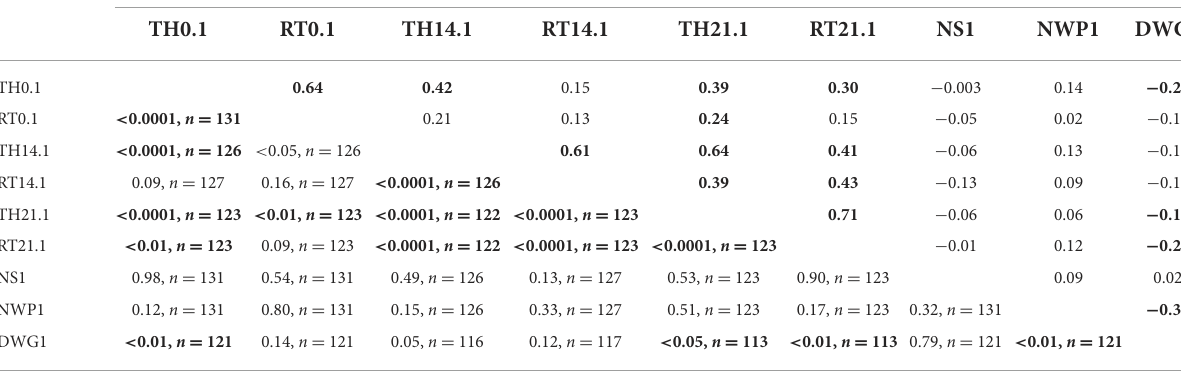
TABLE 3 Pearson correlation coefficient between thermographic skin temperature, rectal temperature, stillborn piglets, number of weaned piglets and daily weight gain of suckling piglets of first parity sows. p -value ( N ) Pearson correlation